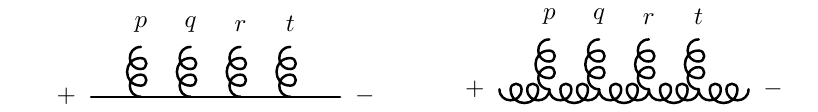
Figure 10 . Forward limits in gluons and scalars that contribute to the half integrand (4.22) are illustrated in the left and right panel, respectively.